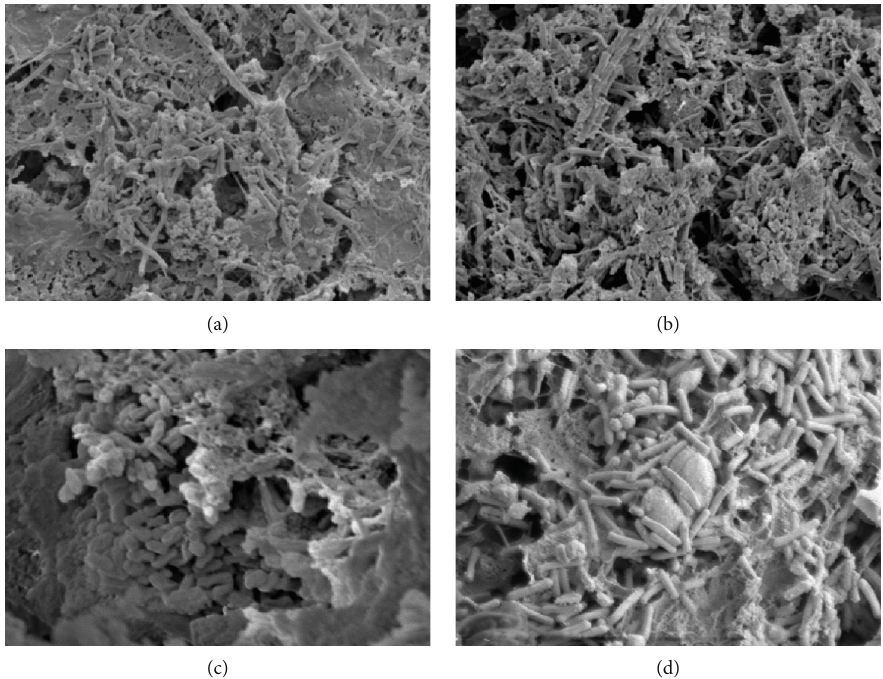
Figure 3: AnAS morphology in Stage I ((a) compartment 1, 5k; (b) compartment 2, 5k; (c) compartment 3, 8 k; and (d) compartment 4, 10 k).